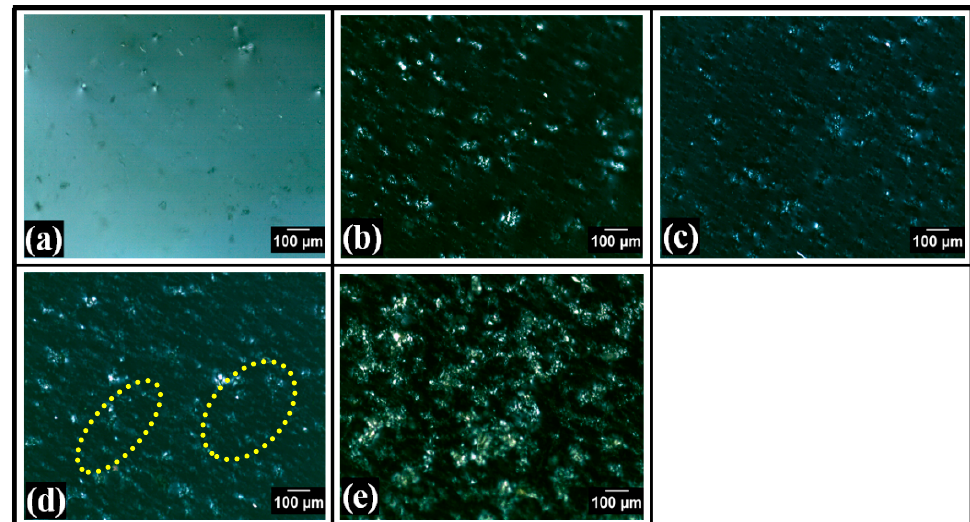
Figure 2. Bright-field micrographs of the films: ( a ) F0, ( b ) F1, ( c ) F2, ( d ) F3, and ( e ) F4.